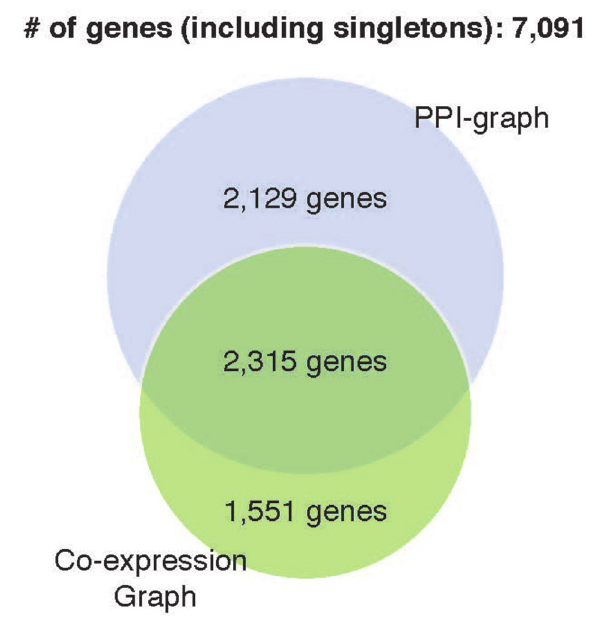
FIGURE 4 | Venn diagram of genes included in four GCNN models. Both singleton graphs contain 7,091 genes. The PPI graph contains 4,444 from the 7,091 genes. The co-expression graph contains 3,866 from the 7,091 genes. The intersection of the PPI graph and the co-expression graph is 2,315